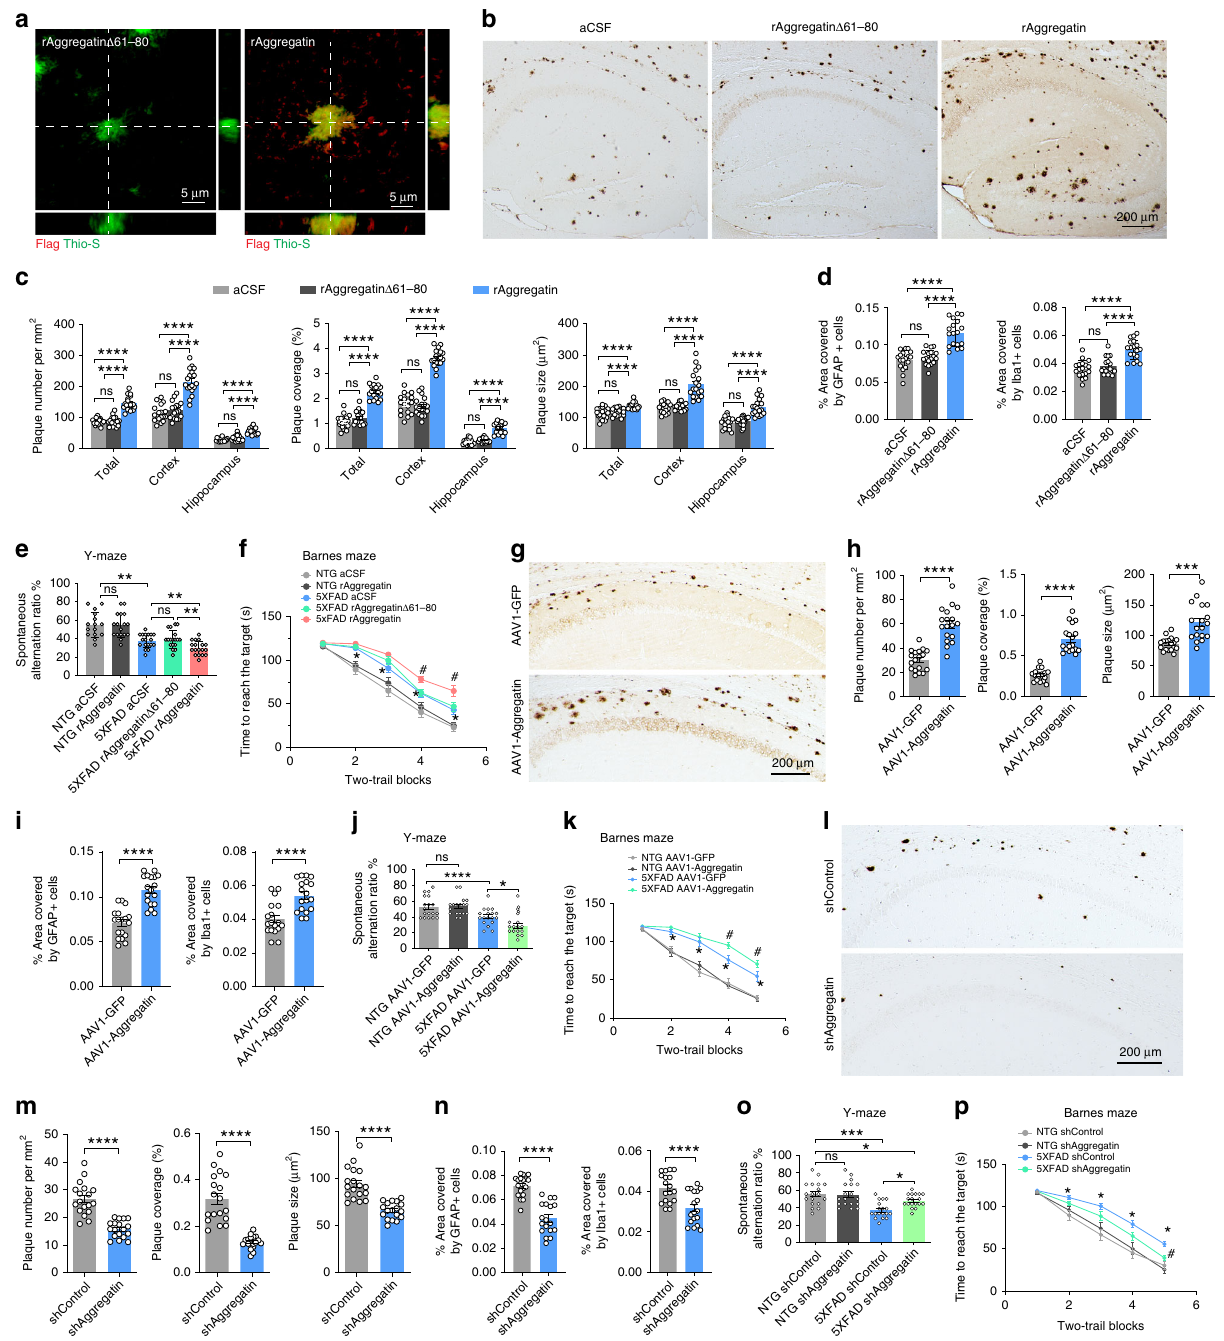
Fig. 5 Aggregatin regulates amyloid deposits. 5-month-old 5xFAD mice were ICV infused with Flag-tagged rAggregatin Δ 61 – 80 or rAggregatin for 4 weeks. a Representative images of Flag-tagged Aggregatin (Red) and amyloid plaques (Green, Thio-S) in the brain. b , c Representative images ( b ) and quanti fi cation ( c ) of plaque by NU-4 antibody in the total brain (Total), cortex or hippocampus ( n = 18 mice in each group). d Quanti fi cation of astrogliosis and microgliosis in hippocampus (representative images shown in Supplementary Fig. 10f). e , f Y-maze ( e ) and Barnes maze ( f ) performance ( n = 15, 17, 18, 18, and 18 mice for NTG aCSF, NTG rAggregatin, 5XFAD aCSF, 5XFAD rAggregatin Δ 61 – 80, and 5XFAD rAggregatin respectively). 5-month-old 5XFAD mice were injected with AAV1-GFP or AAV1-Aggregatin at 1.5 month-old. g , h Representative images ( g ) and quanti fi cation ( h ) of plaques stained by NU-4 in the hippocampus ( n = 18 mice in each group). i Quanti fi cation of astrogliosis and microgliosis in the hippocampus ( n = 18 mice in each group). j , k Y- maze ( j ) and Barnes maze ( k ) performance ( n = 18 mice in each group). Representative images are shown in Supplementary Fig. 11g. 5-month-old 5XFAD mice were injected with AAV1-shControl or AAV1-shAggregatin at 1.5-month-old. l , m Representative images ( h ) and quanti fi cation ( i ) of plaques stained by NU-4 in the hippocampus ( n = 18 mice in each group). n Quanti fi cation of astrogliosis and microgliosis in the hippocampus ( n = 18 mice in each group). Representative images are shown in Supplementary Fig. 12f. o , p Y-maze ( o ) and Barnes maze ( p ) performance ( n = 18 mice in each group). Source data are provided as a Source Data fi le (Source Data for Statistics and Blots). Data are means ± s.e.m. Student ’ s t -test or one and two-way analysis of variance (ANOVA) followed by Tukey ’ s multiple comparison test. * P < 0.05, # P < 0.05 (relative to aCSF, AAV1-GFP or shControl AAV1), *** P < 0.001, **** P < 0.0001. ns, non-signi fi